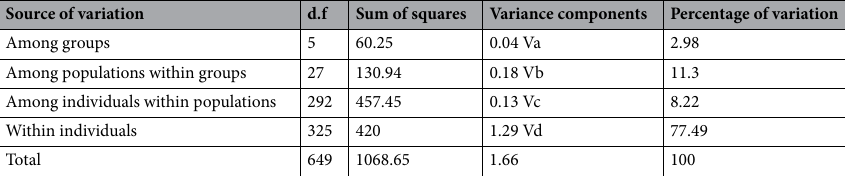
Table 3. analysis of molecular variance (AMOVA) among and within state-based